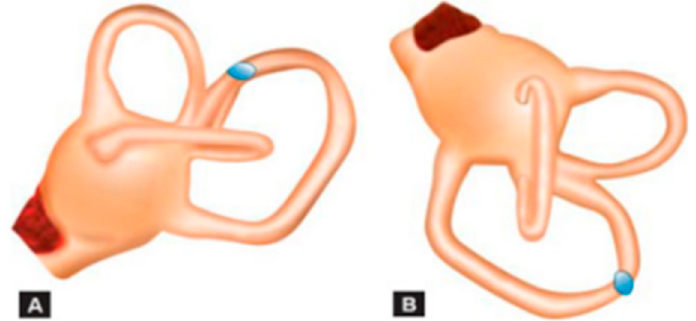
Figure 2. The debris inside the posterior semicircular canal (PSC) close to the common crus ( A ), gravitating toward the PSC ampullary arm ( B